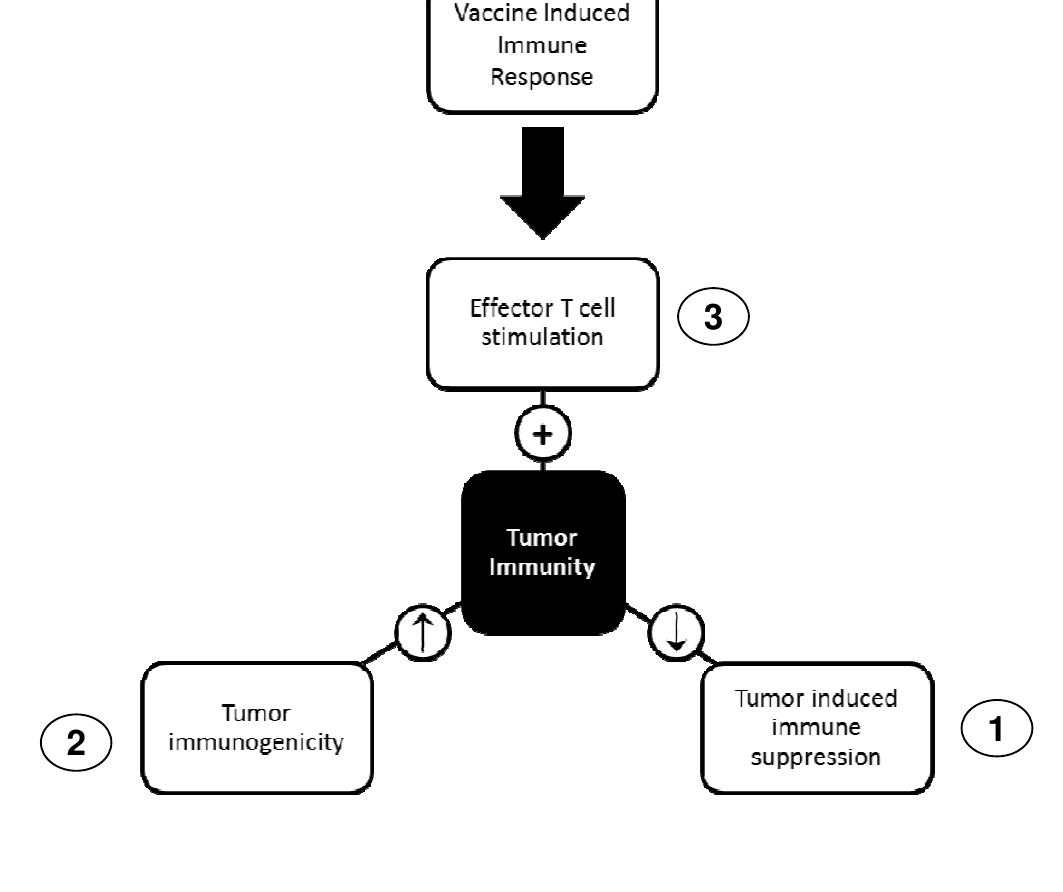
Figure 1. Combined effects of chemotherapy and vaccine therapy on tumor